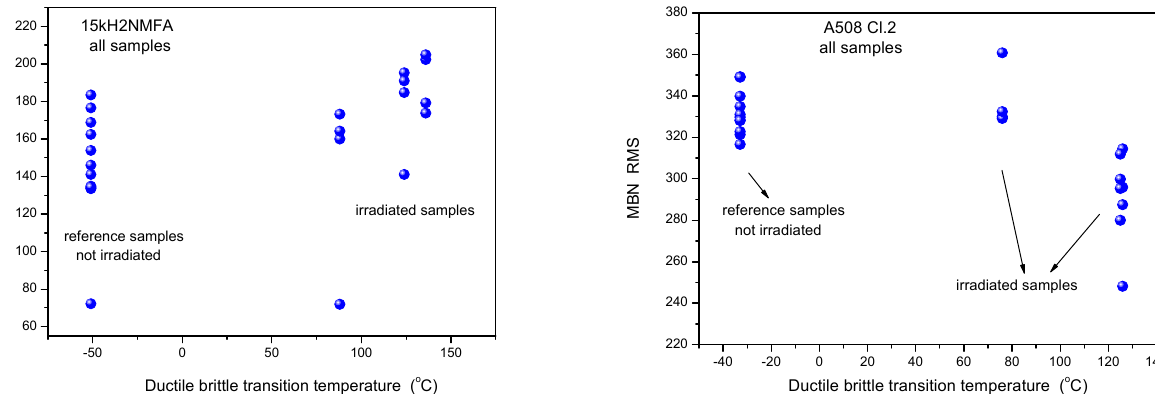
Figure 4. Dependence of the amplitude of third harmonics P3 parameter of 3MA as a function of transition temperature for all measured 15kH2NMFA and A508 Cl.2 samples.